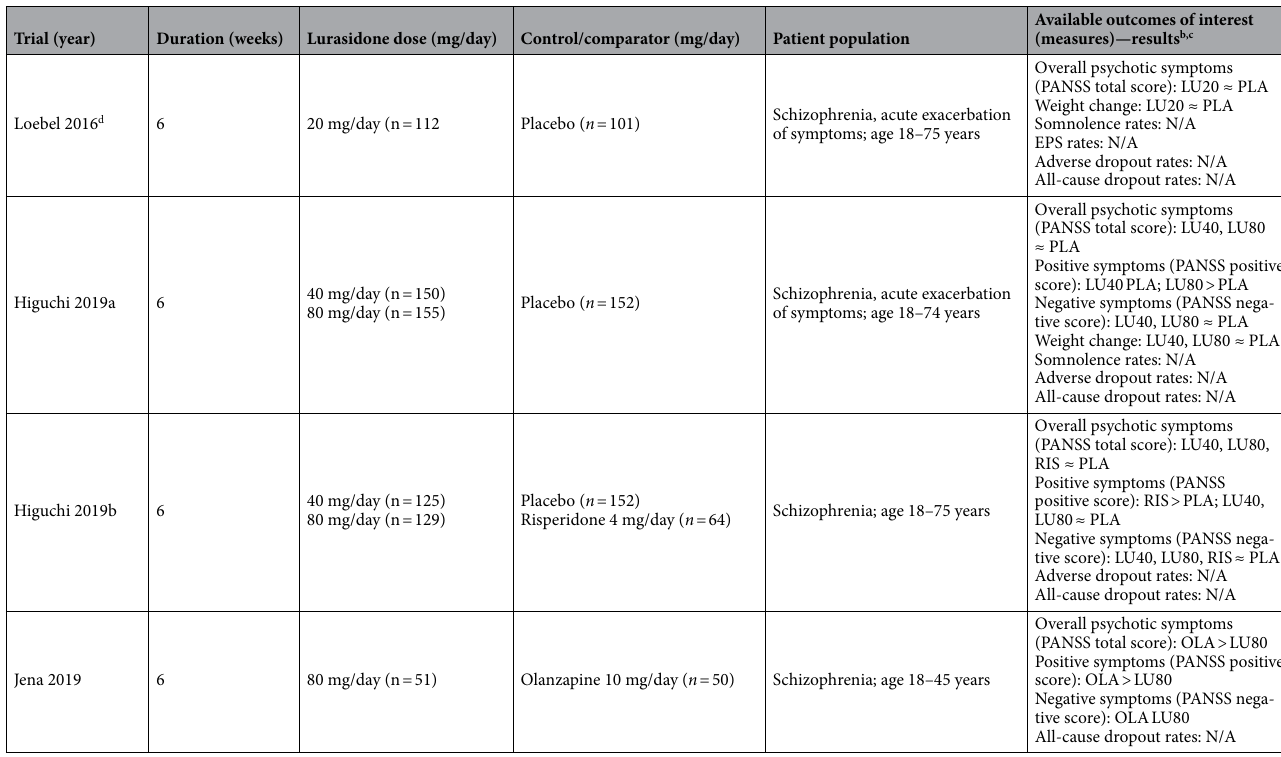
Table 1. Characteristics and key results of the included trials a . a Only the last results of the study. b The symbols of > and ≈ indicate significant superiority ( p < 0.05) and not significant difference (p ≥ 0.05) as being reported by the authors, respectively. c N/A indicates the availability of data but no statistical test being applied. d Participants initiating with lurasidone 80 mg/day were excluded. Those nonresponding to 2-week treatment of lurasidone 80 mg/day were randomized to further received lurasidone 80 mg/day and lurasidone 160 mg/ day. PANSS: Positive and Negative Syndrome Scale; MADRS: Montgomery-Asberg Depression Rating